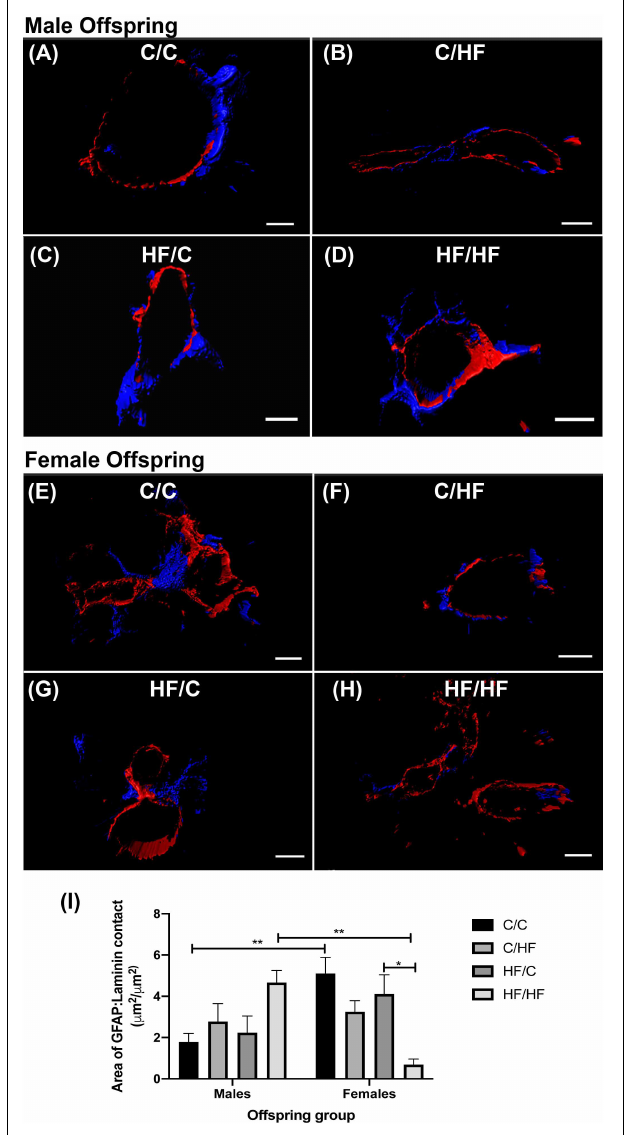
FIGURE 8 | Astrocyte endfoot coverage of hippocampal arteries in male and female offspring. (A–H) Representative images of the 3D reconstruction of GFAP (blue) and laminin (red) staining of hippocampal arteries in male (A–D) and female (E–H) C/C (A,E) , C/HF (B,F) , HF/C (C,G) and HF/HF (D,H) mice. (I) Quantification of the surface area of contact between GFAP-positive astrocytes and laminin in arteries of male and female offspring. Data